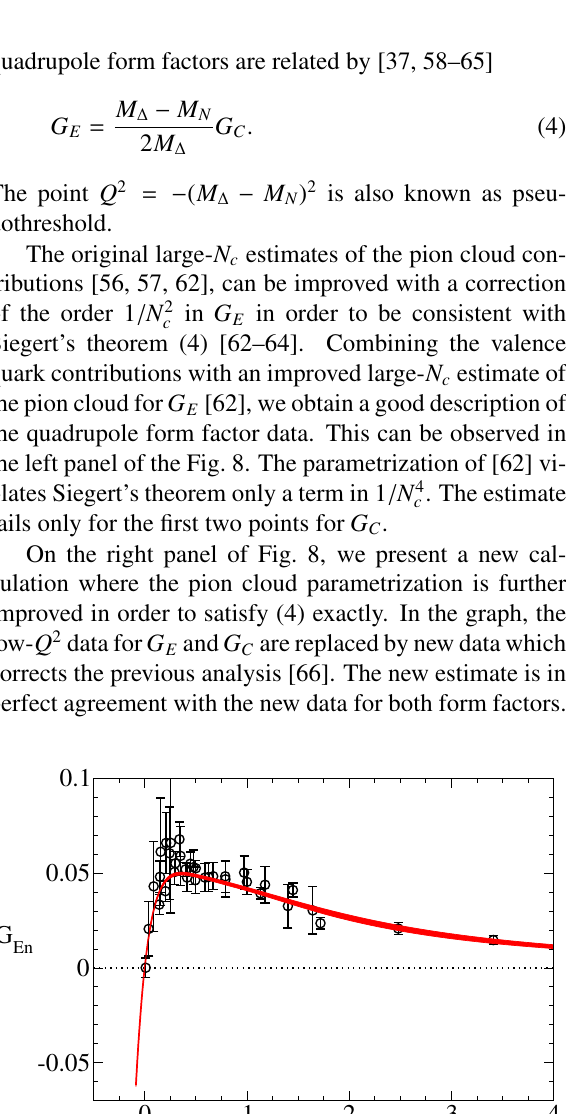
Figure 8. γ ∗ N → Δ (1232) quadrupole form factors. The Coulomb form factor is normalized by κ = M Δ − M N model combines valence quark and pion cloud contributions. Data from [6, 64]. Left: Estimate with pion cloud contribution from [62]. Right: Estimate with pion cloud contribution from [63]. New low- Q 2 data from [66].